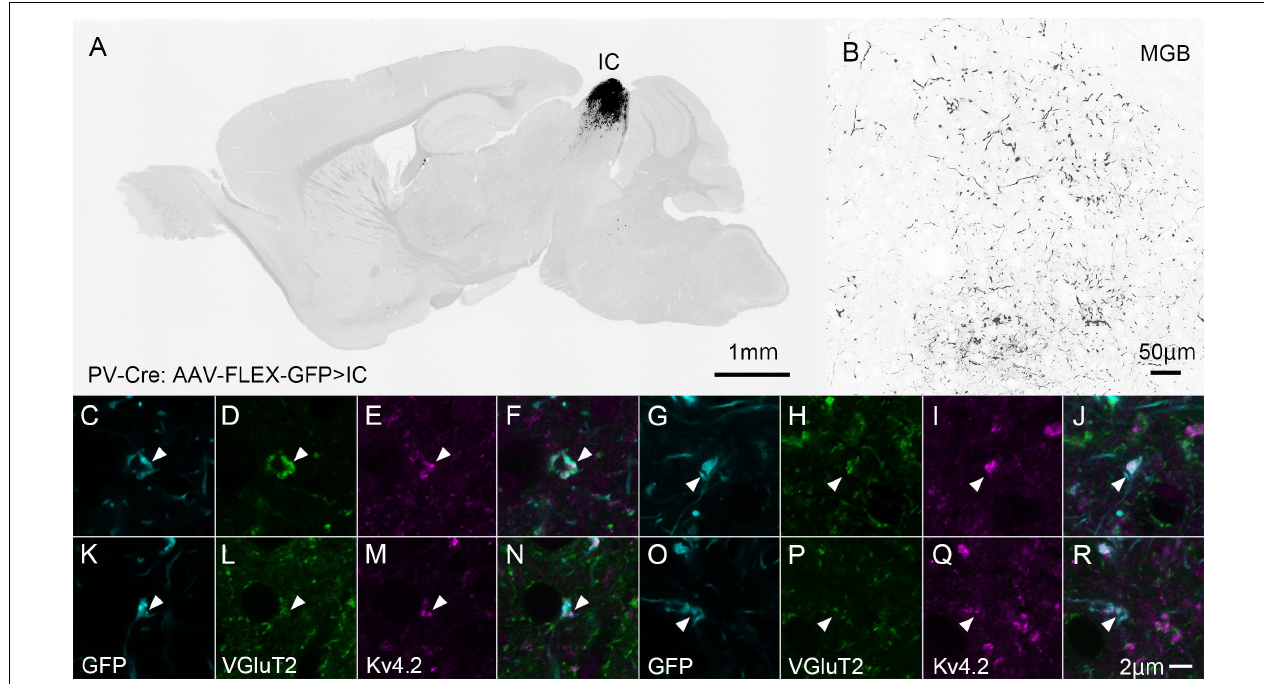
FIGURE 6 | Kv4.2-positive processes from MGV neurons receive excitatory (VGluT2) inputs from the IC (GFP). (A) An example of a GFP-immunostained sagittal section containing IC and showing the center of injection. (B) GFP-positive axonal plexuses in the MGB. (C–R) Triple immunofluorescence for GFP (cyan; C,G,K,O ), VGluT2 (green; D,H,L,P ), and Kv4.2 (magenta; E,I,M,Q ) in the MGVof PV-Cre mice. (F,J,N,R) Images are acquired from different sections. Scale bar: 1 mm (A) , 50 µ m (B) , and 2 µ m (C–R) . GFP, green fluorescent protein; IC, inferior colliculus; Kv4, Shal-related subfamily of potassium voltage-gated channel; MGV, ventral medial geniculate; VGluT2, vesicular glutamate transporter